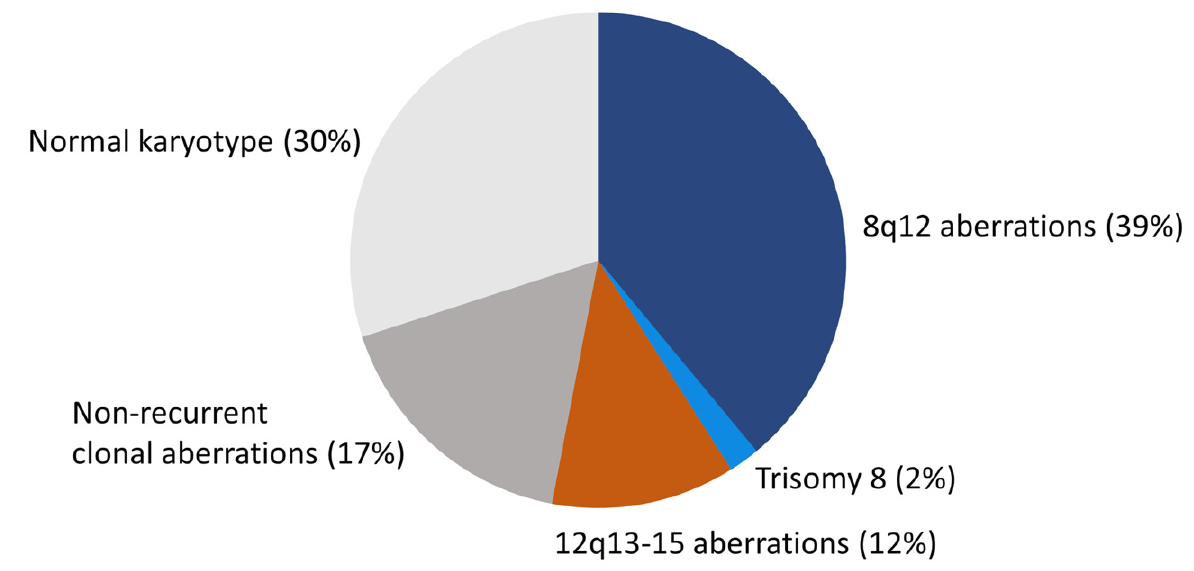
Figure 1. The cytogenetic landscape of PA . Pie chart showing the different cytogenetic subgroups and their frequencies in PA.